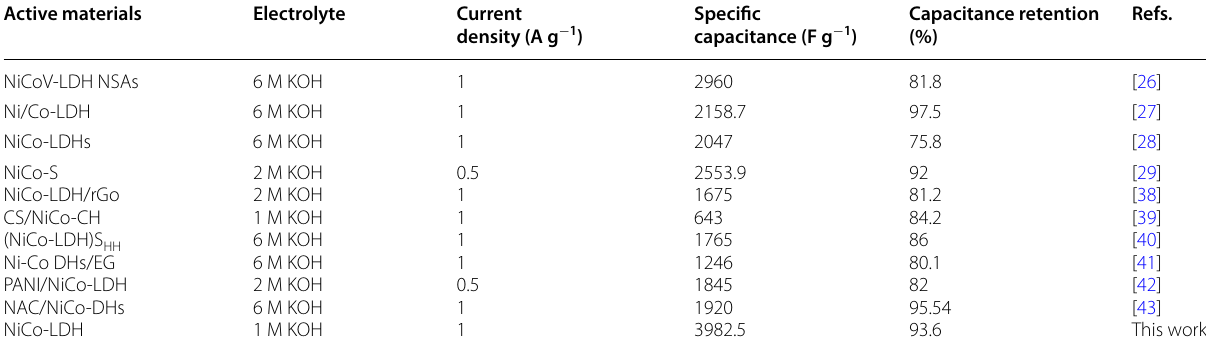
Table 1 Comparison of the performance of our work with those in literature Active